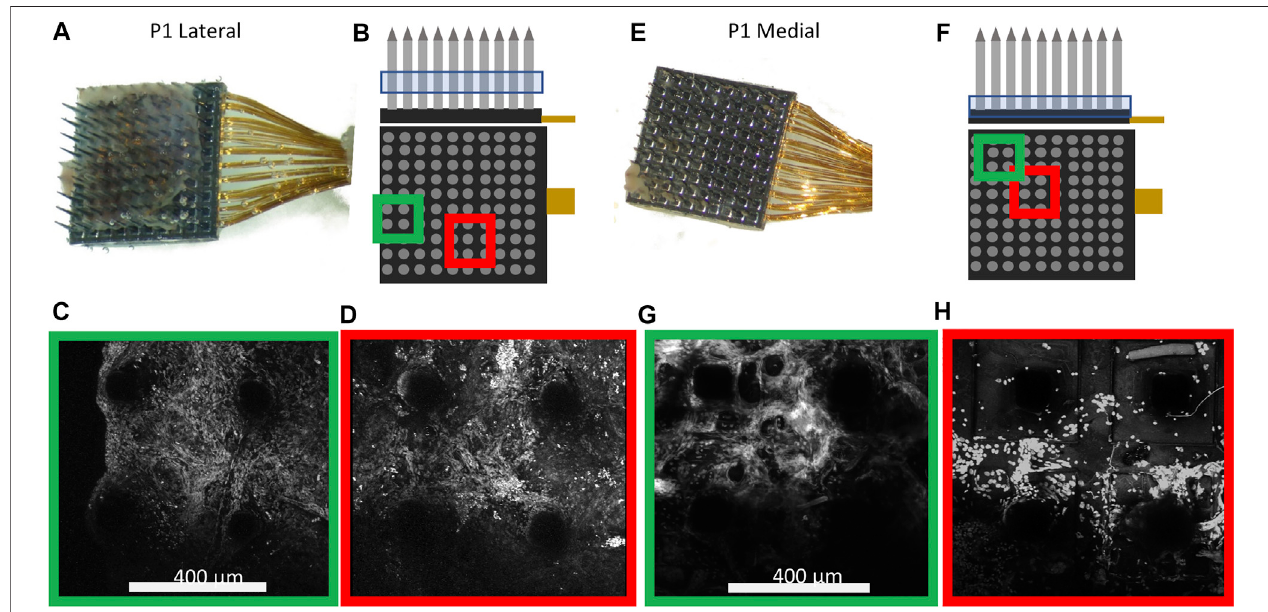
FIGURE 3 | Characterization of the encapsulation of the electrodes. Arrays were imaged with an optical microscope in air. Both arrays are from P1. The encapsulation ofthe lateral array (A) wasfurther examined with TPM. (B) The locationof 2Pimaging alongthe Z axis and select electrode shanks. Thearray was stained forcellnucleiandzoomed-inimagesweretakenofthegreen (C) andred (D) regions.Inbothregionsthereisprominentsecondharmonicsignal,indicatingthepresence of collagen. The medial array in (E) was chosen to display the lack of homogeneity of the encapsulating tissues. (F) Location along the z -axis (blue box) and two selectedareasfurtherimaged.3Drotationimagesweregenerateddisplayingthetissueencapsulationandnucleistainingfromtheregionshighlightedingreen (G) orred (H) . The outerimage (G) displays high secondharmonicsignal while the inner image (H) haselevated cellcounts, demonstrating theheterogeneityofthe